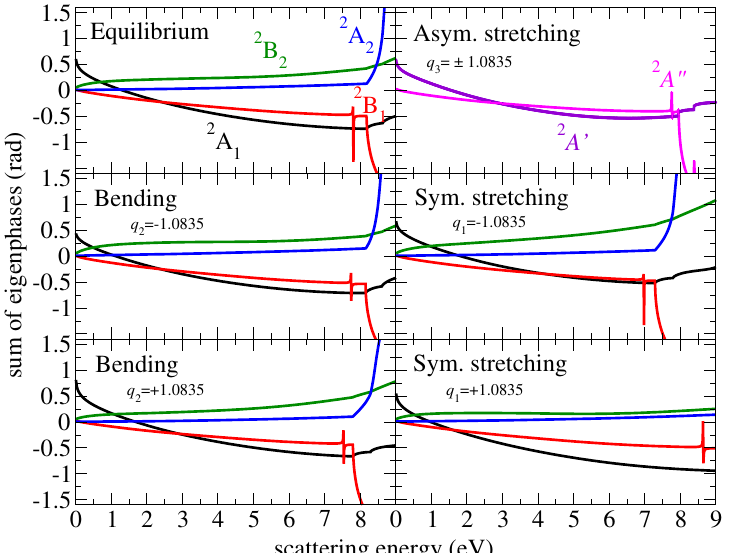
Figure 1. The sum of eigenphases as a function of the electron scattering energy for equilibrium geometry and displacements q i = ± 1.0835 along each normal mode. The eigenphase sums for q 3 = + 1.0835 and q 3 = − 1.0835 of the asymmetric stretching mode are identical. The curves are color coded according the different symmetries of the e − + H 2 O system (see the left upper